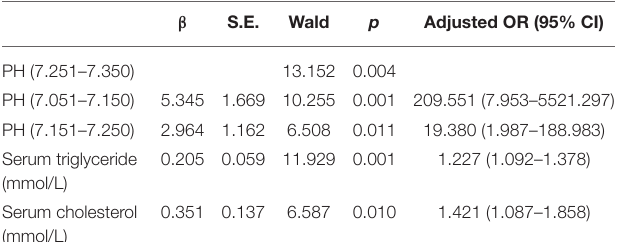
TABLE 3 | Multivariate analysis adjusted odds ratios of factors linked with DKA and AP.